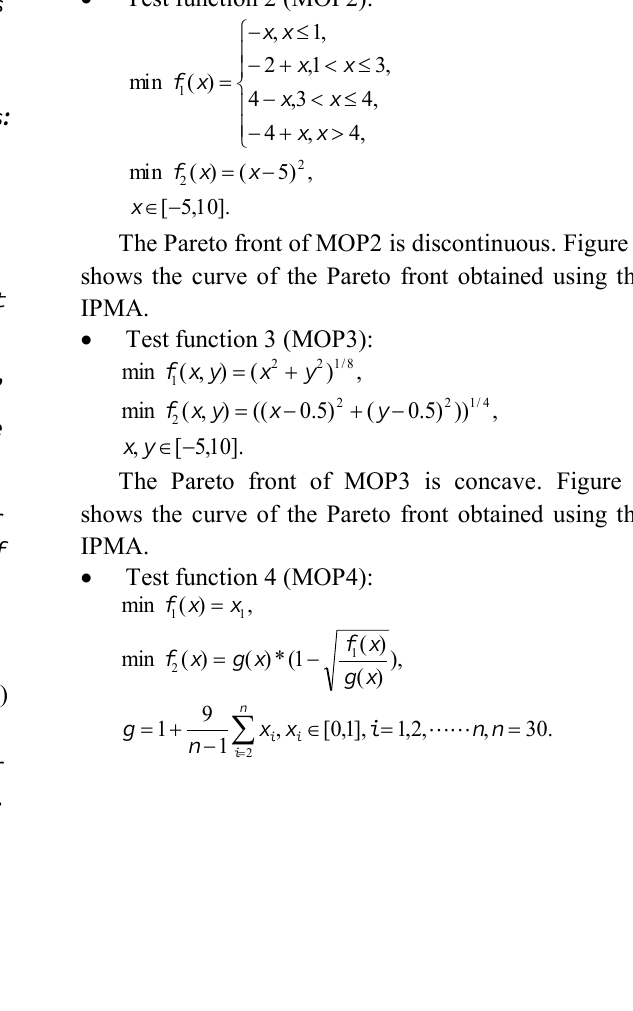
The Pareto front of MOP1 is convex. Figure 1 shows the curve of the Pareto front obtained using the IPMA.